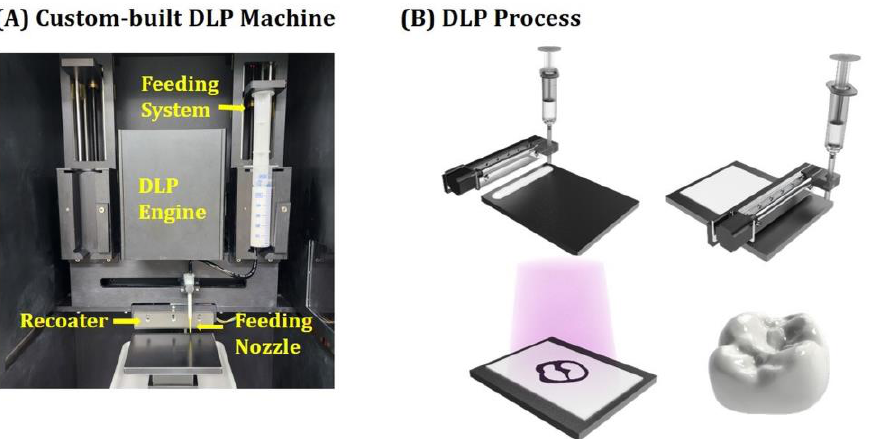
Figure 2. ( A ) Optical image of our custom-built DLP machine and ( B ) schematics showing the DLP process used for manufacturing 5Y-PSZ dental crowns.